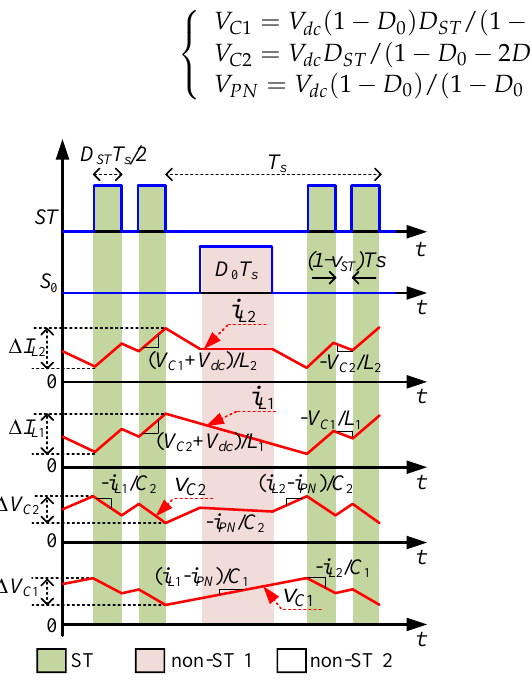
Figure 4. Inductor currents and capacitor voltages in one switching period.